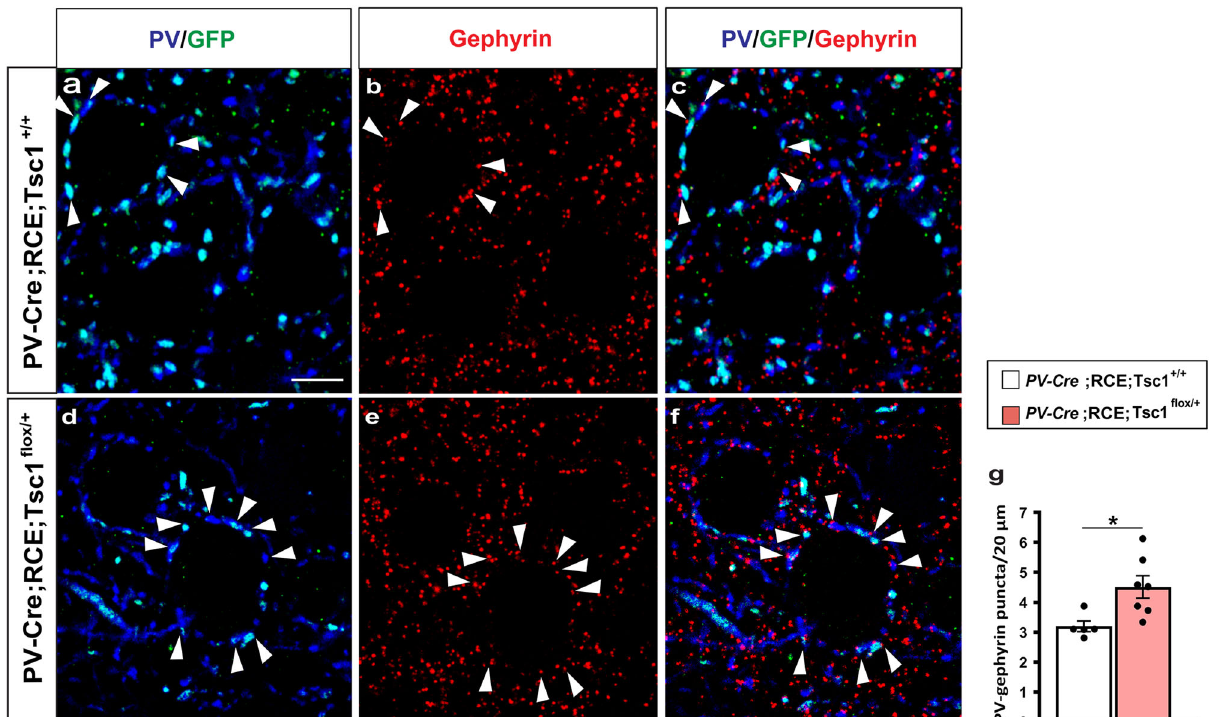
Fig. 8 Postnatal onset of Tsc1 haploinsuf fi ciency in PV cells induces premature putative synapse formation. a – f Representative immunostained sections of somatosensory cortex labeled for PV/GFP (blue/green) and gephyrin (red) in P22 PV-Cre;RCE;Tsc1 + / + ( a – c ) and PV-Cre;RCE;Tsc1 fl ox/ + mice ( d – f ). White arrowheads indicate PV/Gephyrin colocalized puncta ( c and f ). Scale bar: 5 μ m. g Quanti fi cation of PV/GFP-Gephyrin colocalized puncta (Welch ’ s t -test, * p = 0.0121). Number of mice: n = 5 for PV-Cre;RCE;Tsc1 + / + and n = 7 for PV-Cre;RCE;Tsc1 fl ox/ + . Data represent mean ± SEM. Source data are provided as a Source Data fi